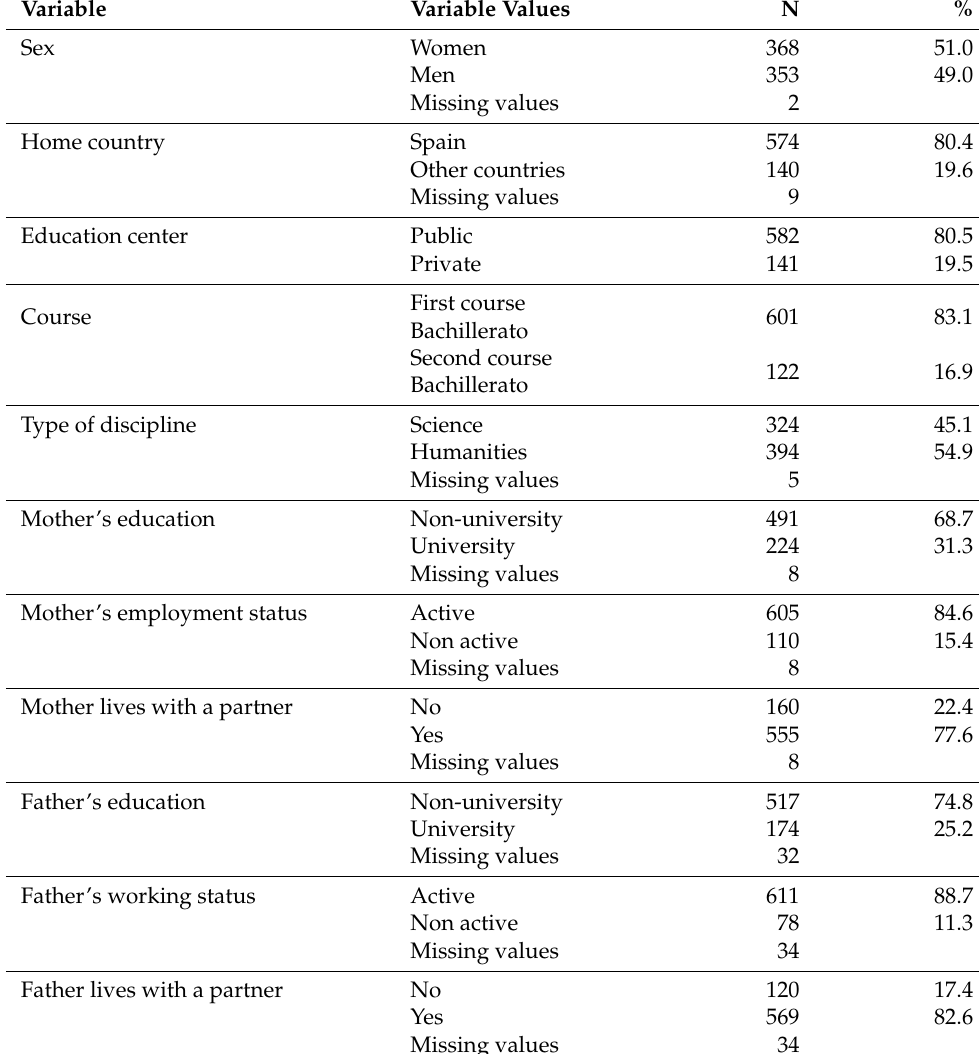
Table 1. Sociodemographic profile of